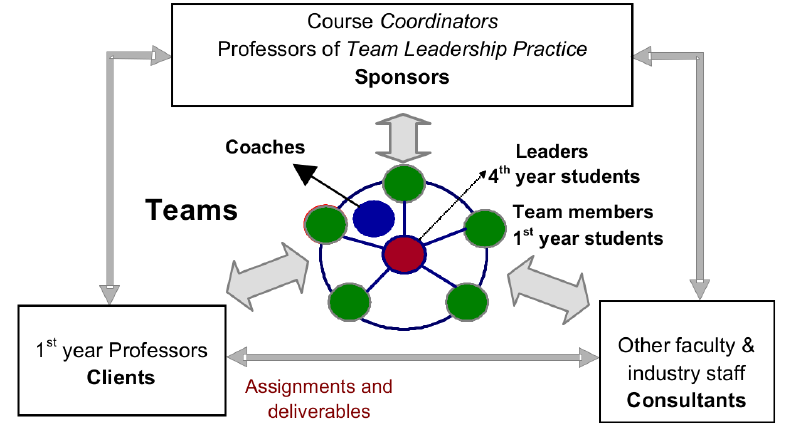
Figure 1. Structure of the teams involved in the IP of the frst academic year